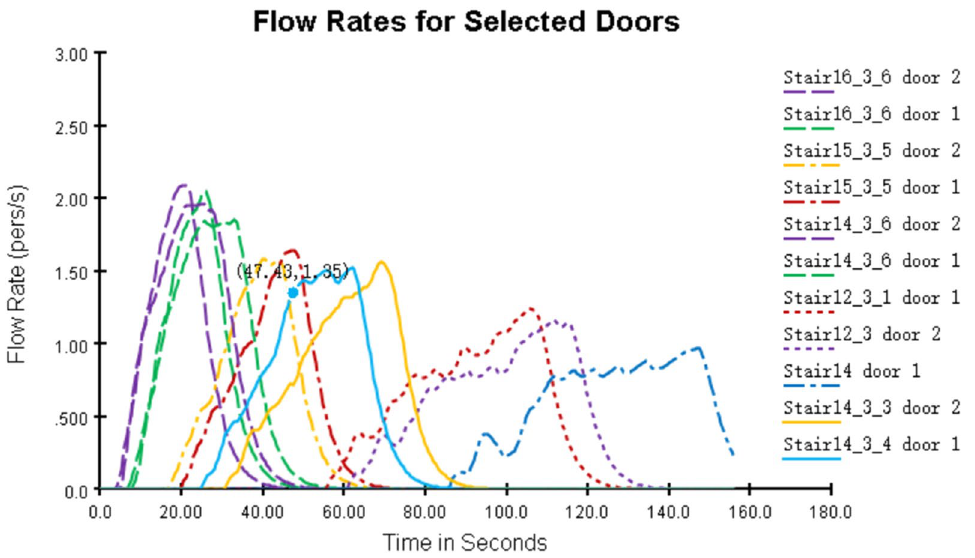
Figure 21. Changes in flow of people at each